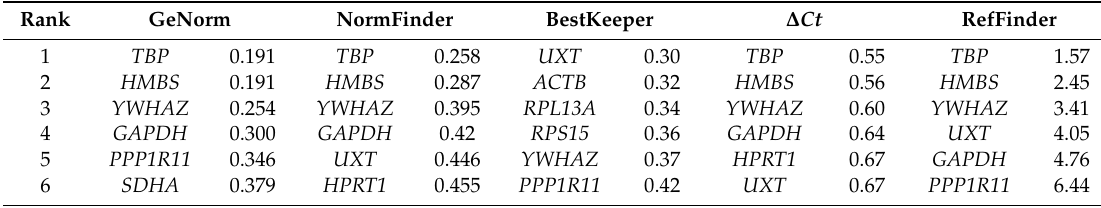
Table 3. Stability of RGs in immature stages of yak